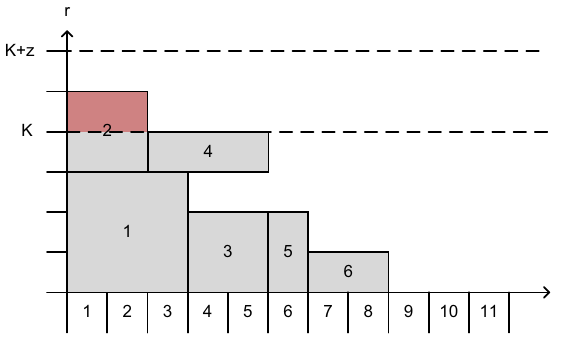
Fig. 3 Schedule with maximum amount of overtime utilized